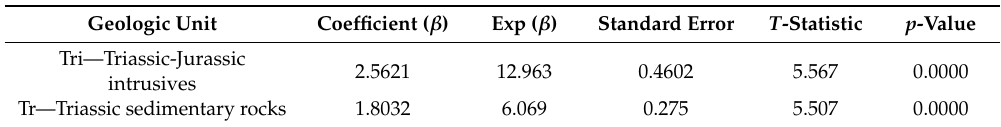
Table 6. Results of the logistic regression model using both datasets ( λ = 0.002, using cross validation). Positive coefficients reflect increased probability of As